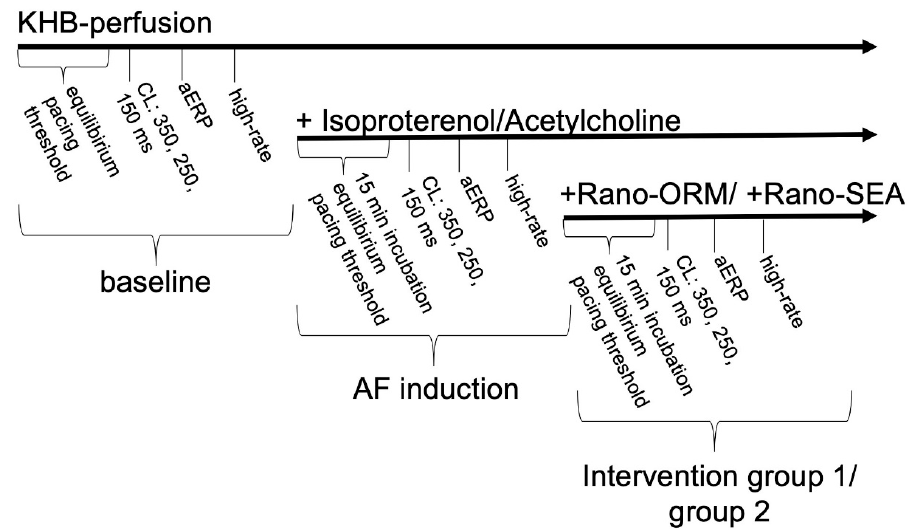
Figure 5. Schematic overview of the experimental protocol. KHB: Krebs-Henseleit-buffer; aERP: atrial effective refractory period; CL: cycle-length.